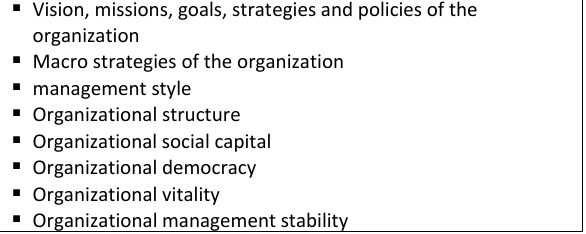
Fig. 1: Strategic human resource management model with the approach of promoting innovation capability in Municipality of